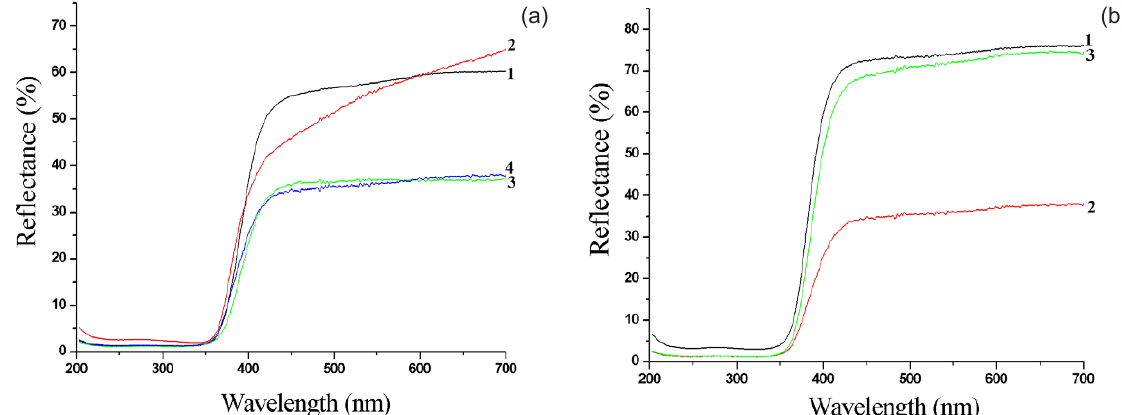
Figure 3. UV-Vis diffused reflectance spectra of: (a) TiO